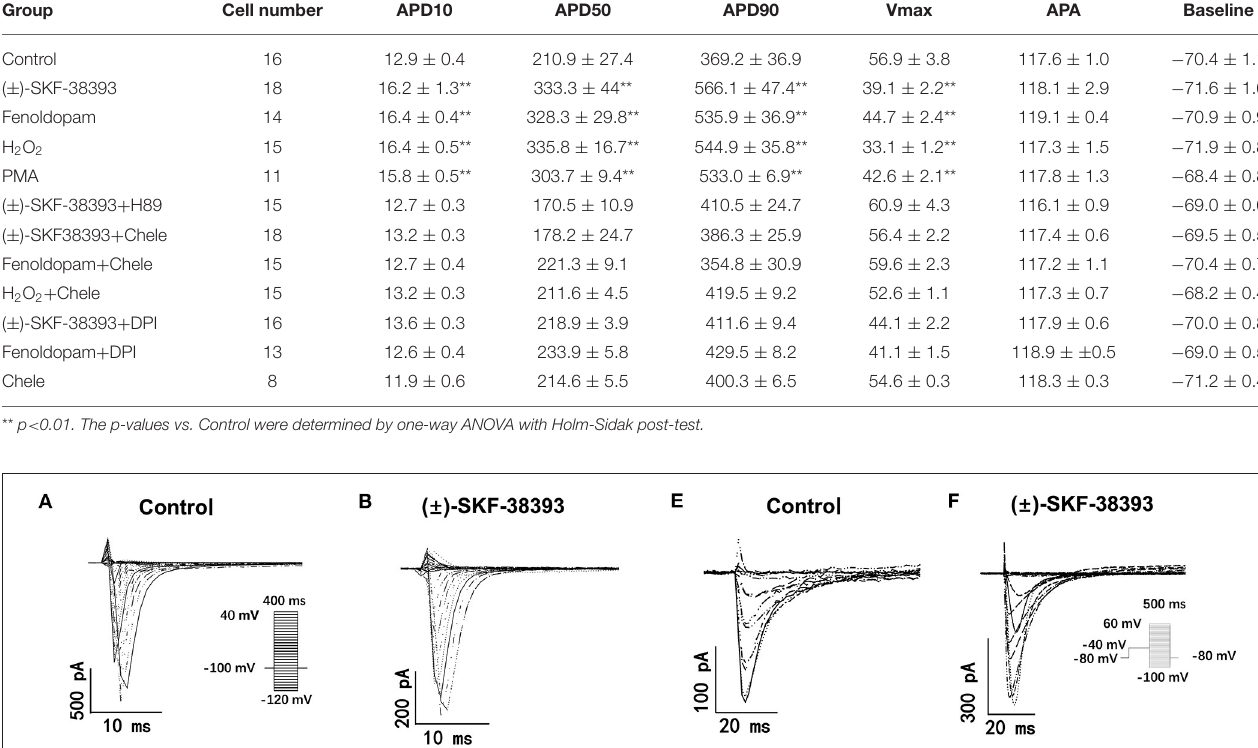
TABLE 3 | Analysis of action potentials influenced by ROS, PKC, and PKA signaling in presence of dopamine receptor agonists. Group Cell number APD10 APD50 APD90 Vmax APA Baseline Control 16